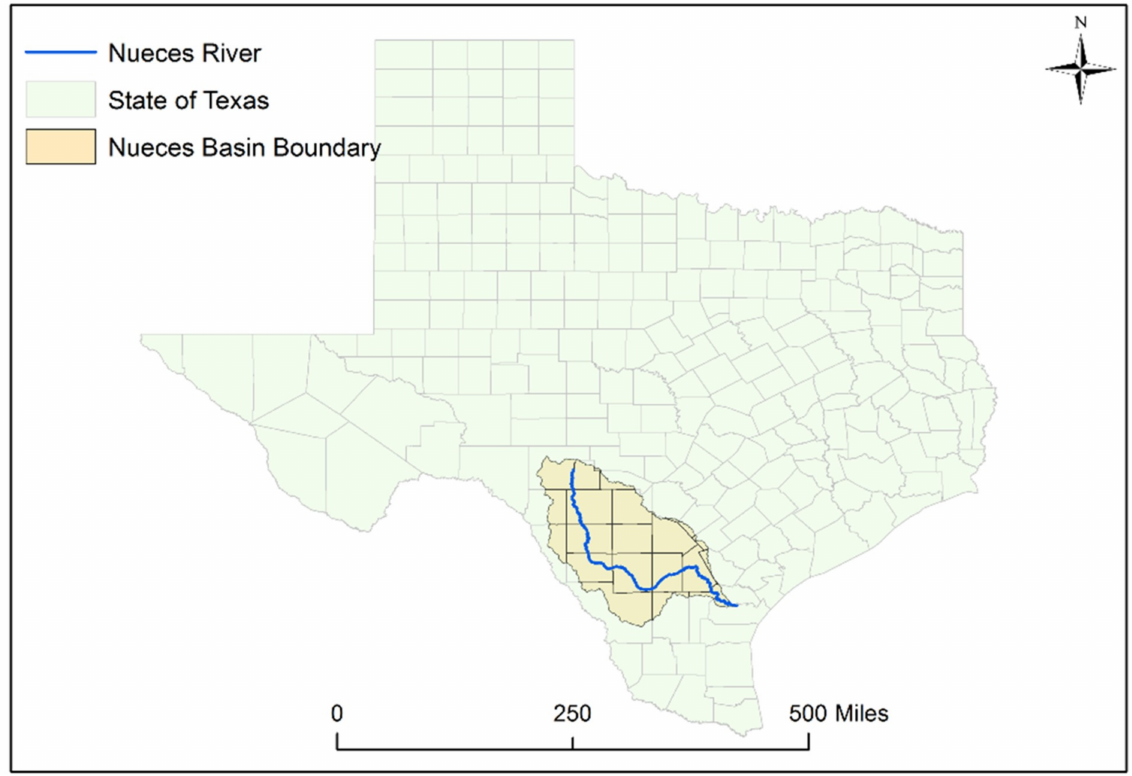
Figure 2. Study area: Nueces River Basin in TX,